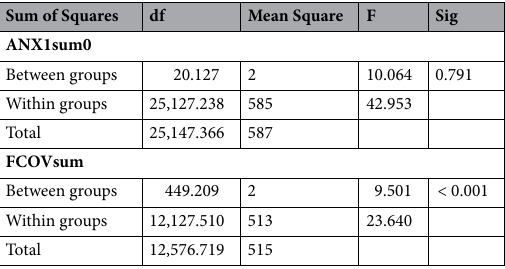
Table 8. Results of ANOVA test between three groups according the intention to get vaccinated. ANX sums of GAD-7 scale, FCOV sums of FCV-19S scale, df degree of freedom, F F distribution value. Sig.